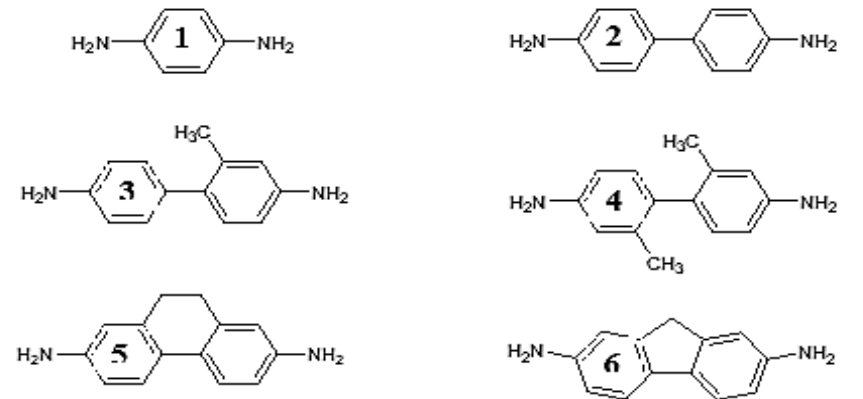
Figure 1: Molecular structures of biphenyl molecules with terminal group amine (NH varying bridge-link atoms